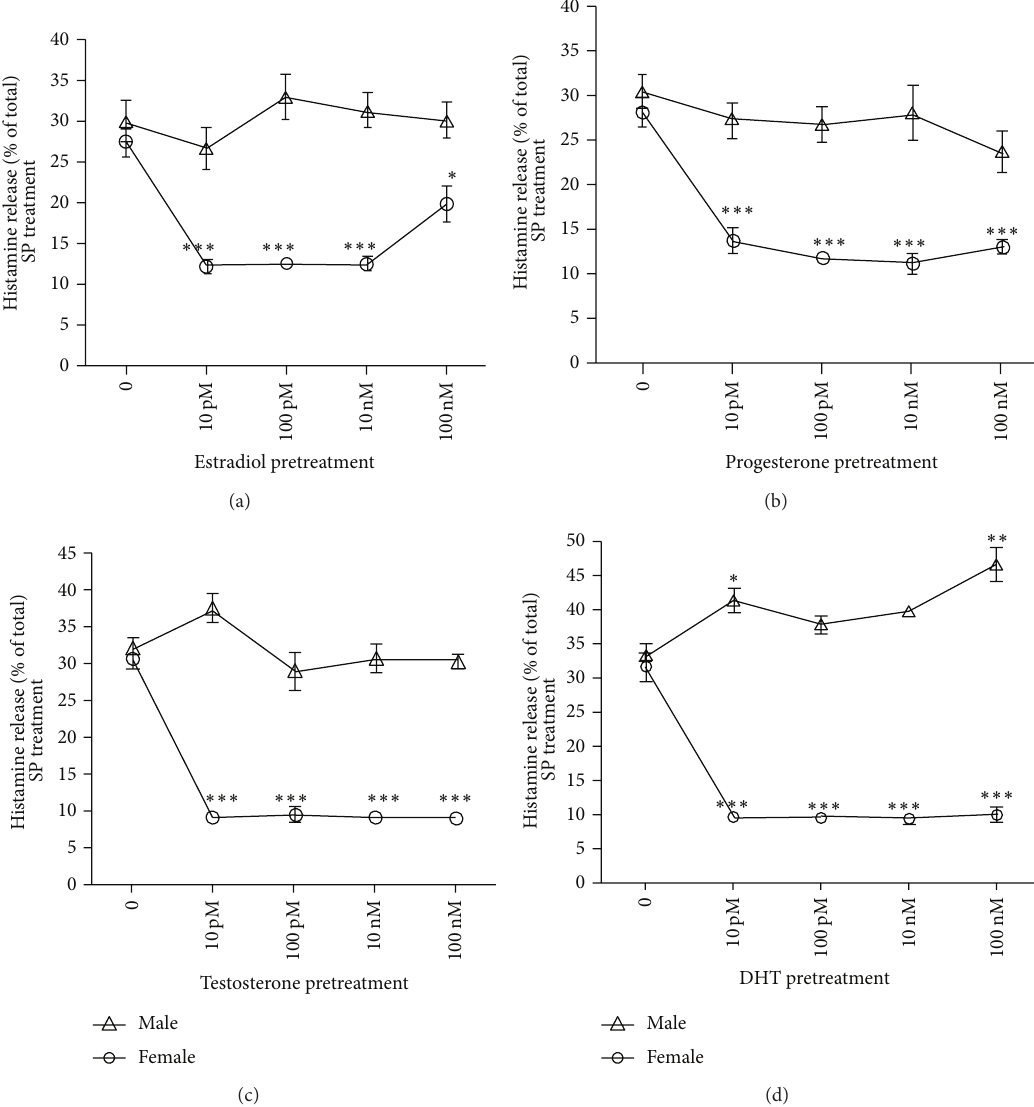
Figure 2: Effect of gender and sex steroid concentration on histamine release induced by substance P in mast cells. Rat PMCs were pretreated with E 2 , P 4 , T 4 , and DHT at 10 pM to 10nM for 90 min at 37 ∘ C, followed by 30min incubation with 10 𝜇 M of substance P. Values are means ± SEM of three independent experiments in triplicate. ∗ 𝑃 < 0.05 , ∗∗ 𝑃 < 0.01 , and ∗∗∗ 𝑃 < 0.001 with and without hormone. Comparisons between genders were performed by one-way analysis of variance (ANOVA), followed by Bonferroni’s multiple comparison test (GraphPad Prism). Hormone concentration and gender had significant effect and the interaction is statistically significant ( 𝑃 < 0.001